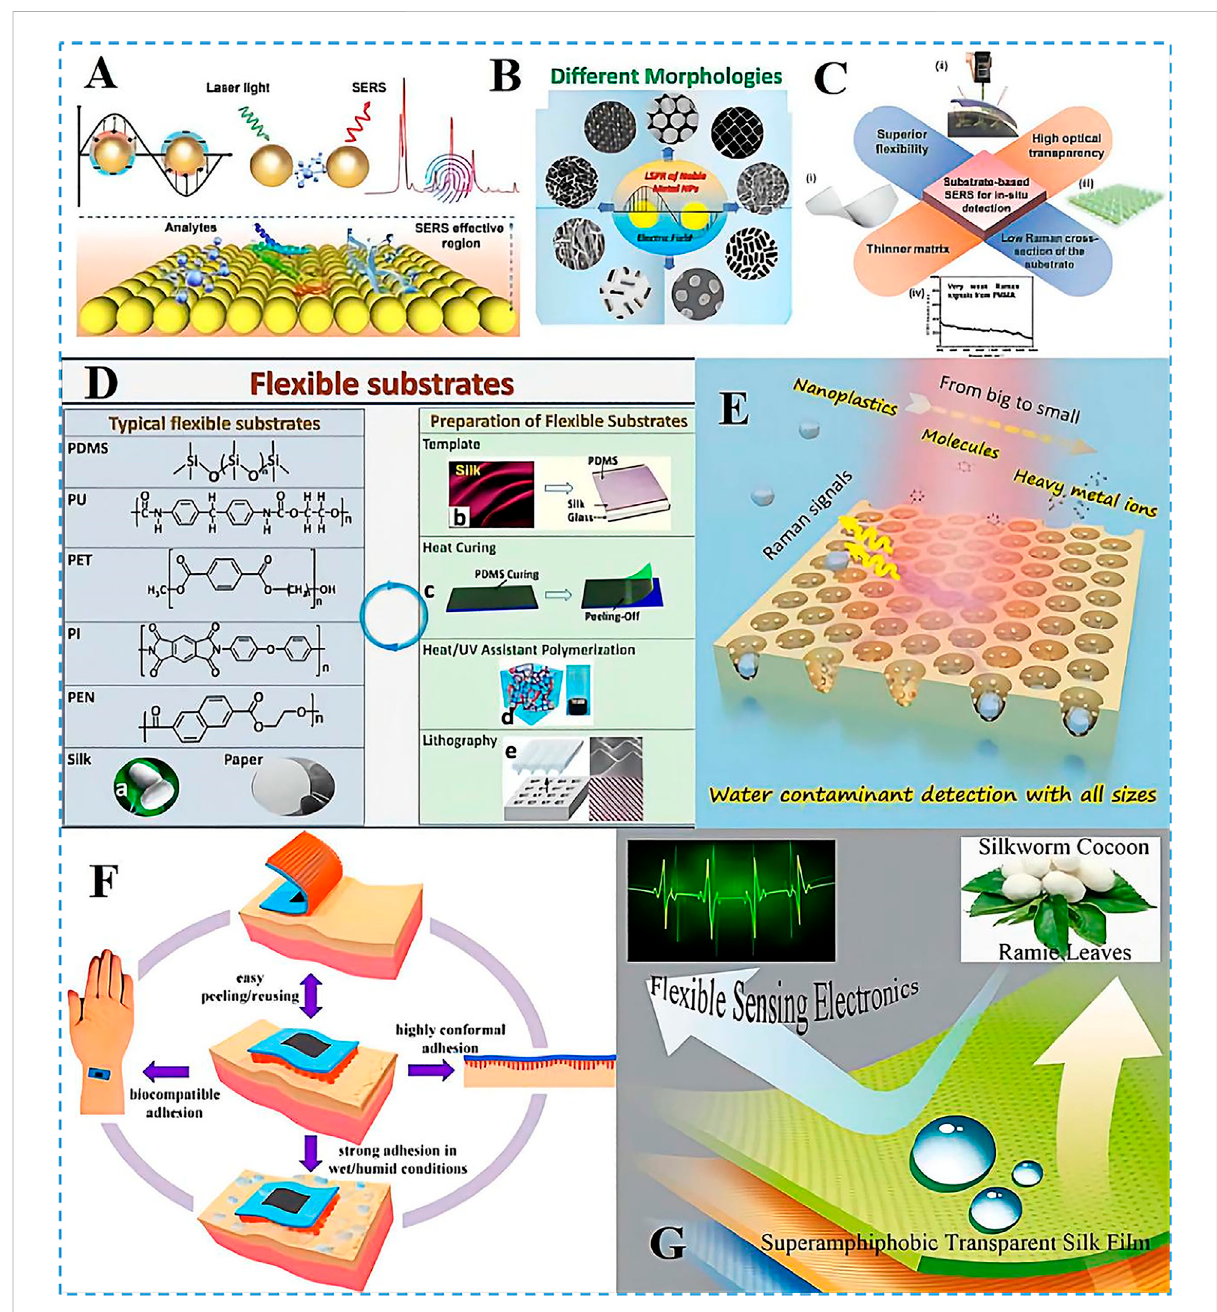
FIGURE 1 WearableSERSsensordesignanddevelopment. (A) SchematicdiagramoftheprincipleofSERSdetectionanalyte. (B) localizedsurfaceplasmon resonance(LSPR)effectsbasedonnoblemetalnanoparticleswithdifferentmorphologies.Copyright © TsinghuaUniversityPressandSpringer-Verlag GmbH Germany, part of Springer Nature 2021. (C) The crucial features of substrate-based SERS for in situ detection. (i-ii) Flexible materials and excitation laser lasers. (iii) SERS substrates. Copyright © 2017, American Chemical Society. (iv) Raman signals from polymethyl methacrylate. Copyright © 2014, American Chemical Society. (D) Typical types of fl exible substrates and preparation methods in fl exible SERS substrates: (A) . Silkworm cocoon optical photo; (B) . Preparation of fl exible substrates by stencil method; (C) . Preparation of fl exible substrates by thermosetting spinning; (D) . Preparation of fl exible substrates by heat/UV-assisted polymerization; (E) . Preparation of fl exible substrates by a photolithography stencil method. Reprinted (adapted) with permission from. Copyright © 2021 American Chemical Society. (E) AAO/MoS2/Ag 3D PIC structure SERS substrate working principle and detection size. Reprinted (adapted) with permission from. Copyright © 2022 American Chemical Society. (F) Characteristics of the MSFA material. Reprinted (adapted) with permission from. Copyright © 2020 American Chemical Society. (G) An integrated silk membrane with special wettability shows excellent self-cleaning, transparency, and fl exible sensing properties under harsh conditions. Reprinted (adapted) with permission from. Copyright © 2020 American Chemical